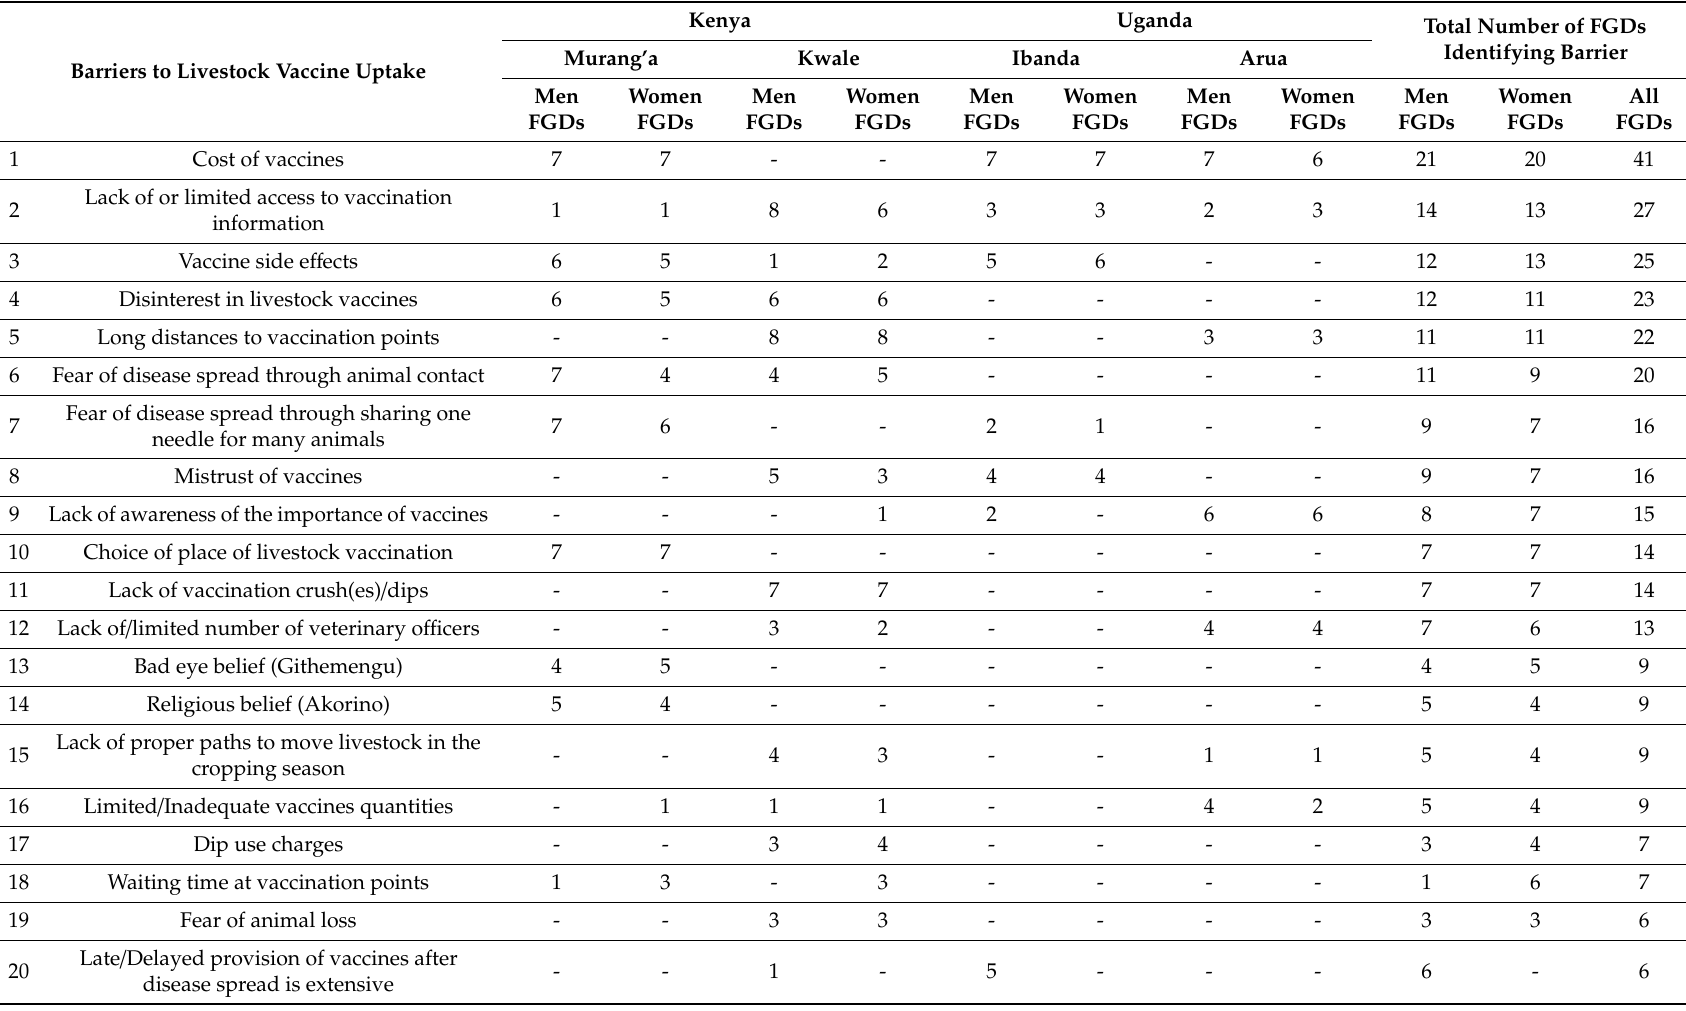
Table 2. List of livestock vaccine uptake barriers identified by men and women